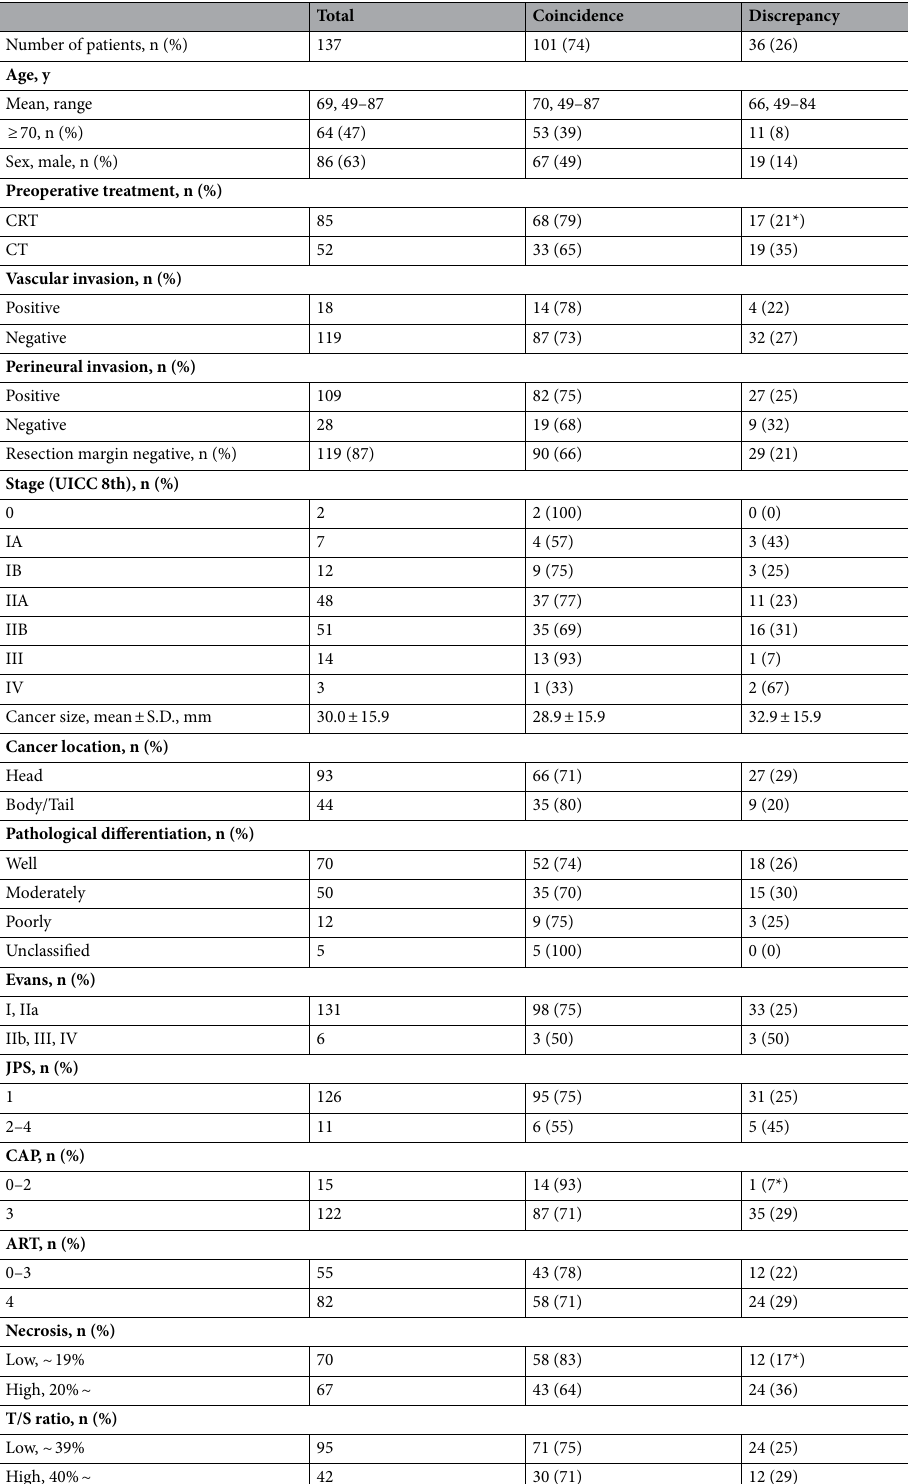
Table 1. Clinicopathological characteristics of patients with pancreatic cancer that underwent neoadjuvant therapy, showing the coincidence or discrepancy between macroscopy and histology. CRT, chemoradiation; CT chemotherapy.; UICC, Union for International Cancer Control; T/S ratio, tumor stroma ratio. *P < 0.05 versus the coincidence group. Evans, JPS, CAP and ART scores were determined by all